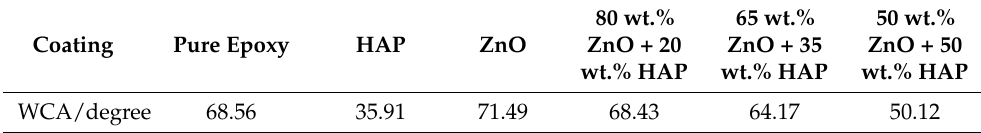
Table 5. Results of water contact angle of coatings with different